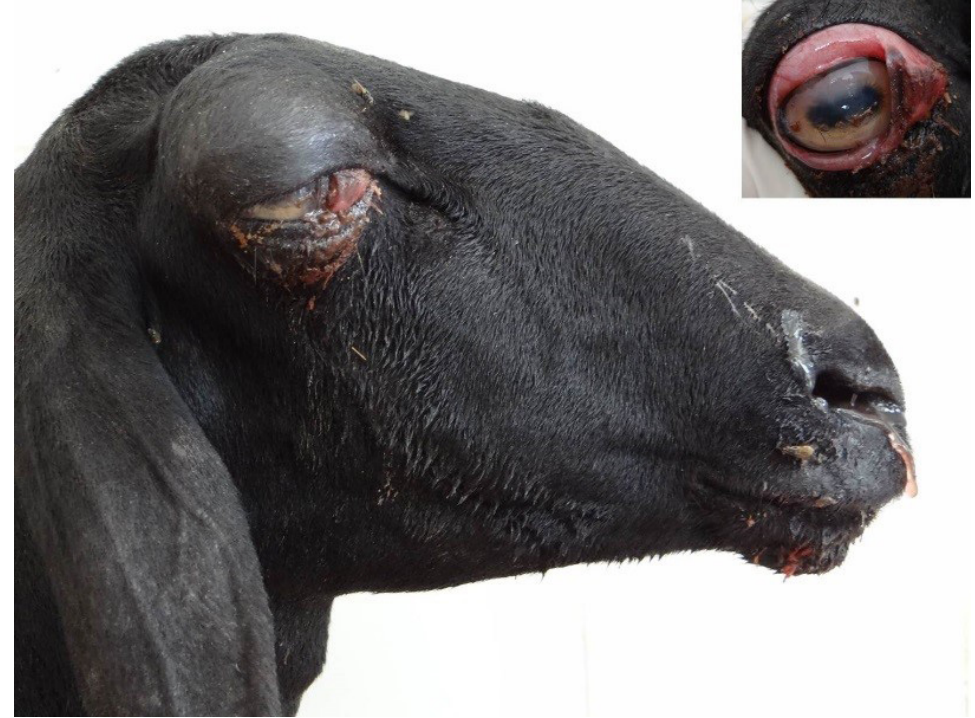
figura 2. Ovino 2PS acometido por conidiobolomicose exibindo intensa exoftalmia e epífora direita, secreção nasal serossanguinolenta bilateral. No detalhe, hiperemia e edema conjuntival